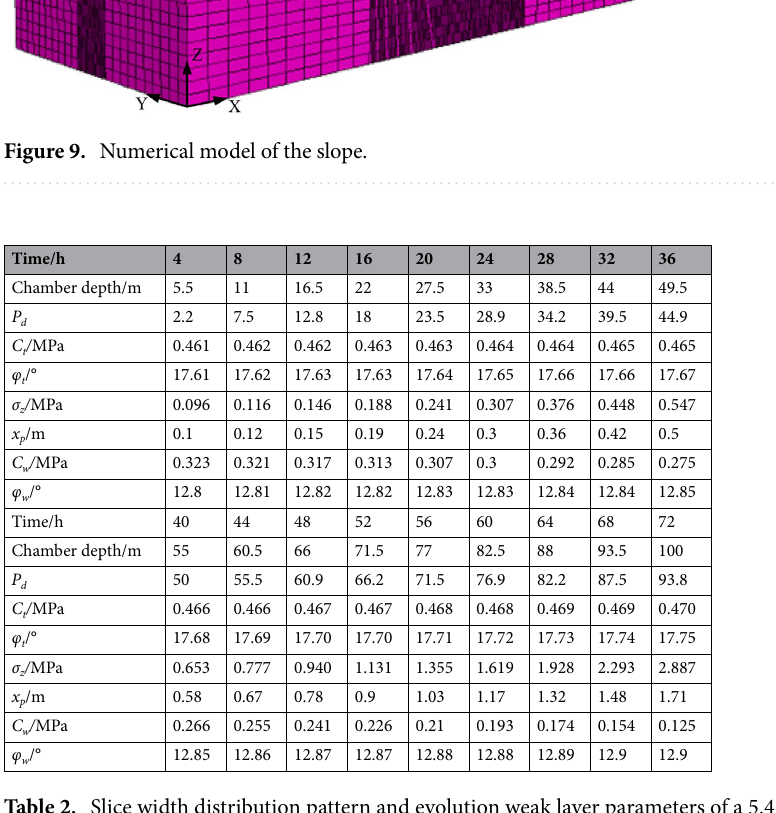
Table 2. Slice width distribution pattern and evolution weak layer parameters of a 5.4-m-wide coal pillar.